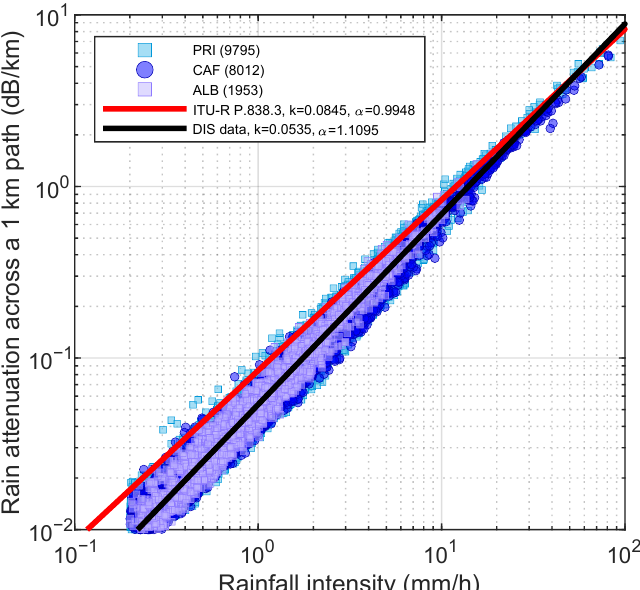
Figure 6. γ - R regression curve from disdrometer data relative to 15 rainfall events in Valmalenco (frequency: 18.8 GHz, polarization: V, direction of incidence: horizontal). In red is the ITU-R γ - R relationship. The numbers in brackets are the rainy minutes recorded by each